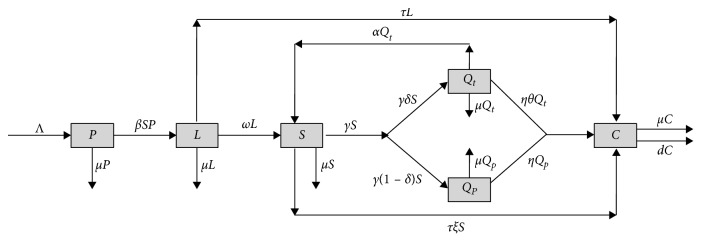
Flow chart of system (1).